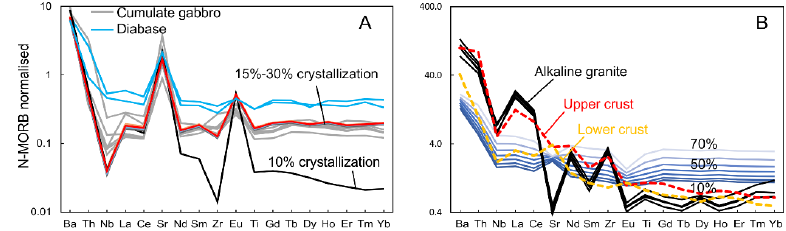
Figure 11. Trace element modelling for fractional crystallization. The initial composition is 13HC-003-3 and the mineral phases are from MELTS modelling. ( A ) Mineral accumulation process. The cumulate is instantaneous mineral assemblage so the equation for fractional crystallization, i.e., C Residual = C O × D × F (D-1) is adopted. ( B ) Melt composition due to fractionation process. The blue lines are the melt composition with 10% interval ranging from 10% to 70% crystallization. The equation C Melt = C O × F (D-1) is adopted. The alkaline granite is from Wang et al. (2018)